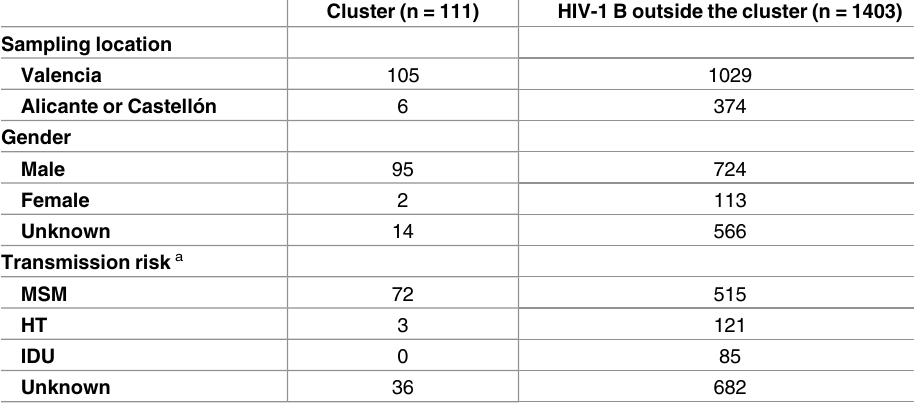
Table 1. Epidemiological characteristics of the